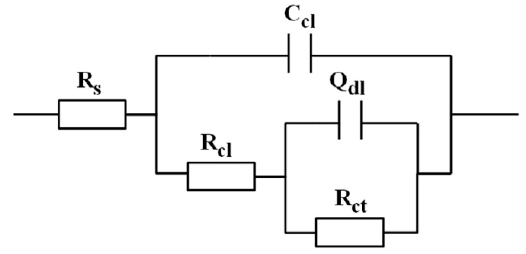
Figure 10. Electrical equivalent circuit diagrams to fit the impedance spectra of LA143 and YAl 2p /LA143 in 3.5% NaCl solution in Figure 9. R s : solution resistance; C cl : corrosion layer capacitance;